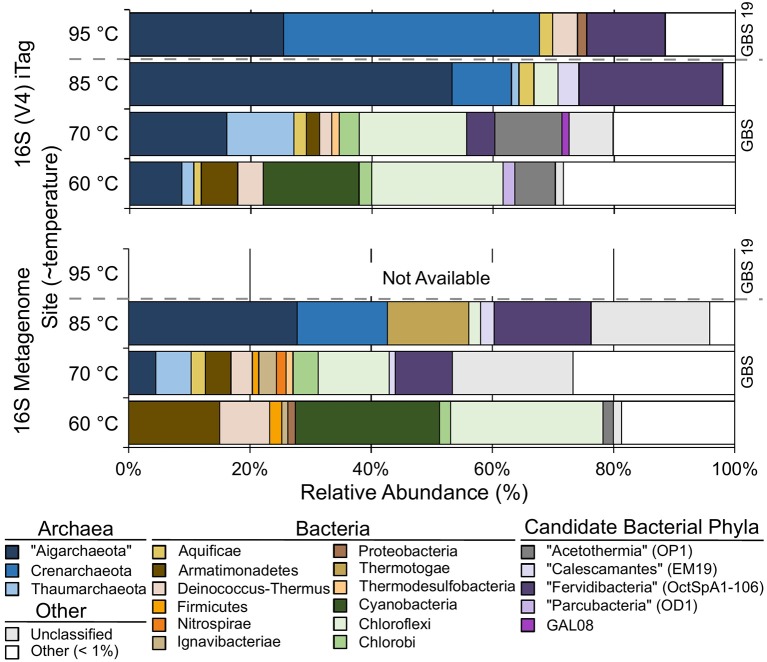
The relative abundance of phylum-level groups for each sample based on 16S rDNA Illumina Tags (iTags) of the V4 region compared with metagenome-derived 16S rDNA. Colored rows show the relative abundance of phyla present at >1% and correspond to the site label on the left. Unclassified sequences are represented as a single group; see Table S3 for information on individual unclassified groups and their abundance. Gray dashed bar indicates GBS 19 is a separate geothermal pool from the main pool. Metagenomic data from GBS 19 is not available due to low DNA yield.